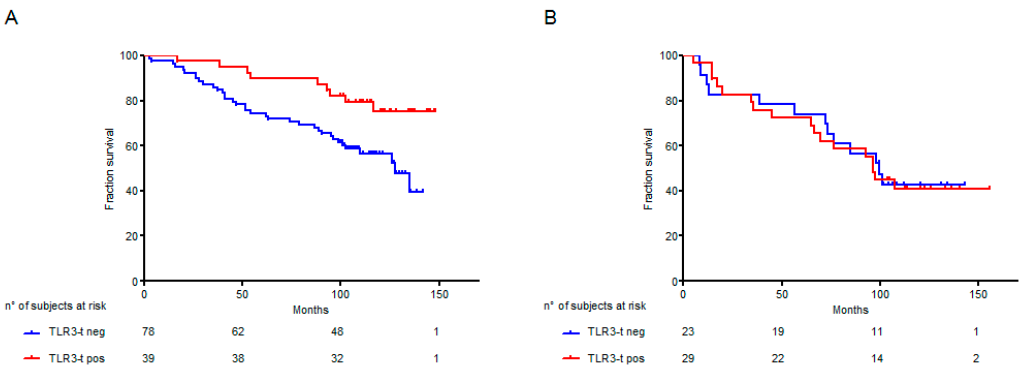
Figure 3. Kaplan–Meier plots of Overall Survival (OS) according to NSCLC histotype and TLR3 immunohistochemistry expression. The relationship between TLR3 expression and prognosis, according to NSCLC histotype, was examined in a cohort of NSCLC specimens, collected at Fondazione IRCCS Istituto Nazionale Tumori Milan [13]. NSCLC cases were considered positive for TLR3 expression (TLR3-t) with a percentage of positive tumor cells > 50%. ( A ) Kaplan–Meier plots of OS of 117 adenocarcinoma NSCLC patients stratified according to TLR3-t immunohistochemistry expression; ( B ) Kaplan–Meier plots of OS of 52 squamous NSCLC patients stratified according to TLR3-t immunohistochemistry expression; Red line: cases positive for TLR3-t expression; blue line: cases negative for TLR3-t expression.